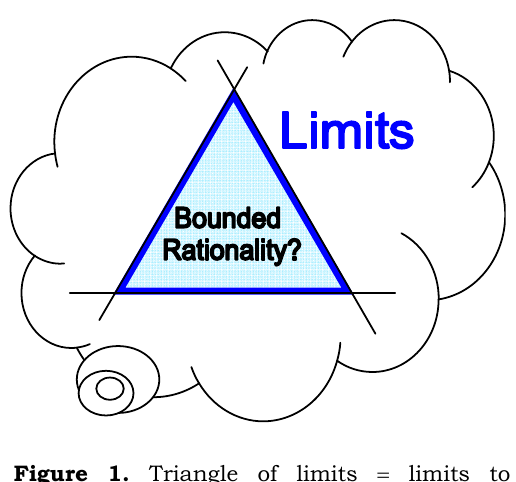
Figure 1. Triangle of limits  limits to rationality/limits of